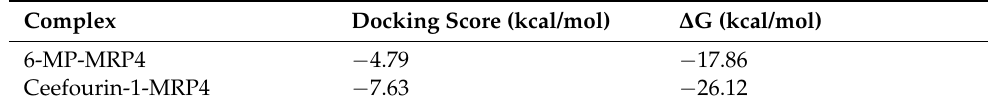
Table 2. Docking Scores and binding energies ( ∆ Gs) of the MRP4 complexes.